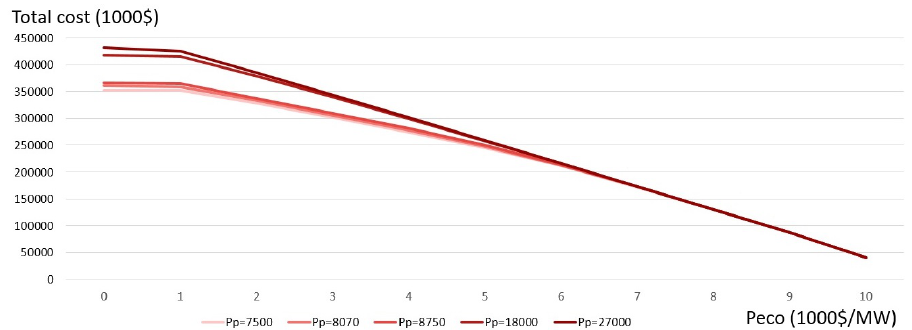
Figure 6. Variation of the total cost with respect to P eco and P p in ($/MW) for the case of certainty (own results).